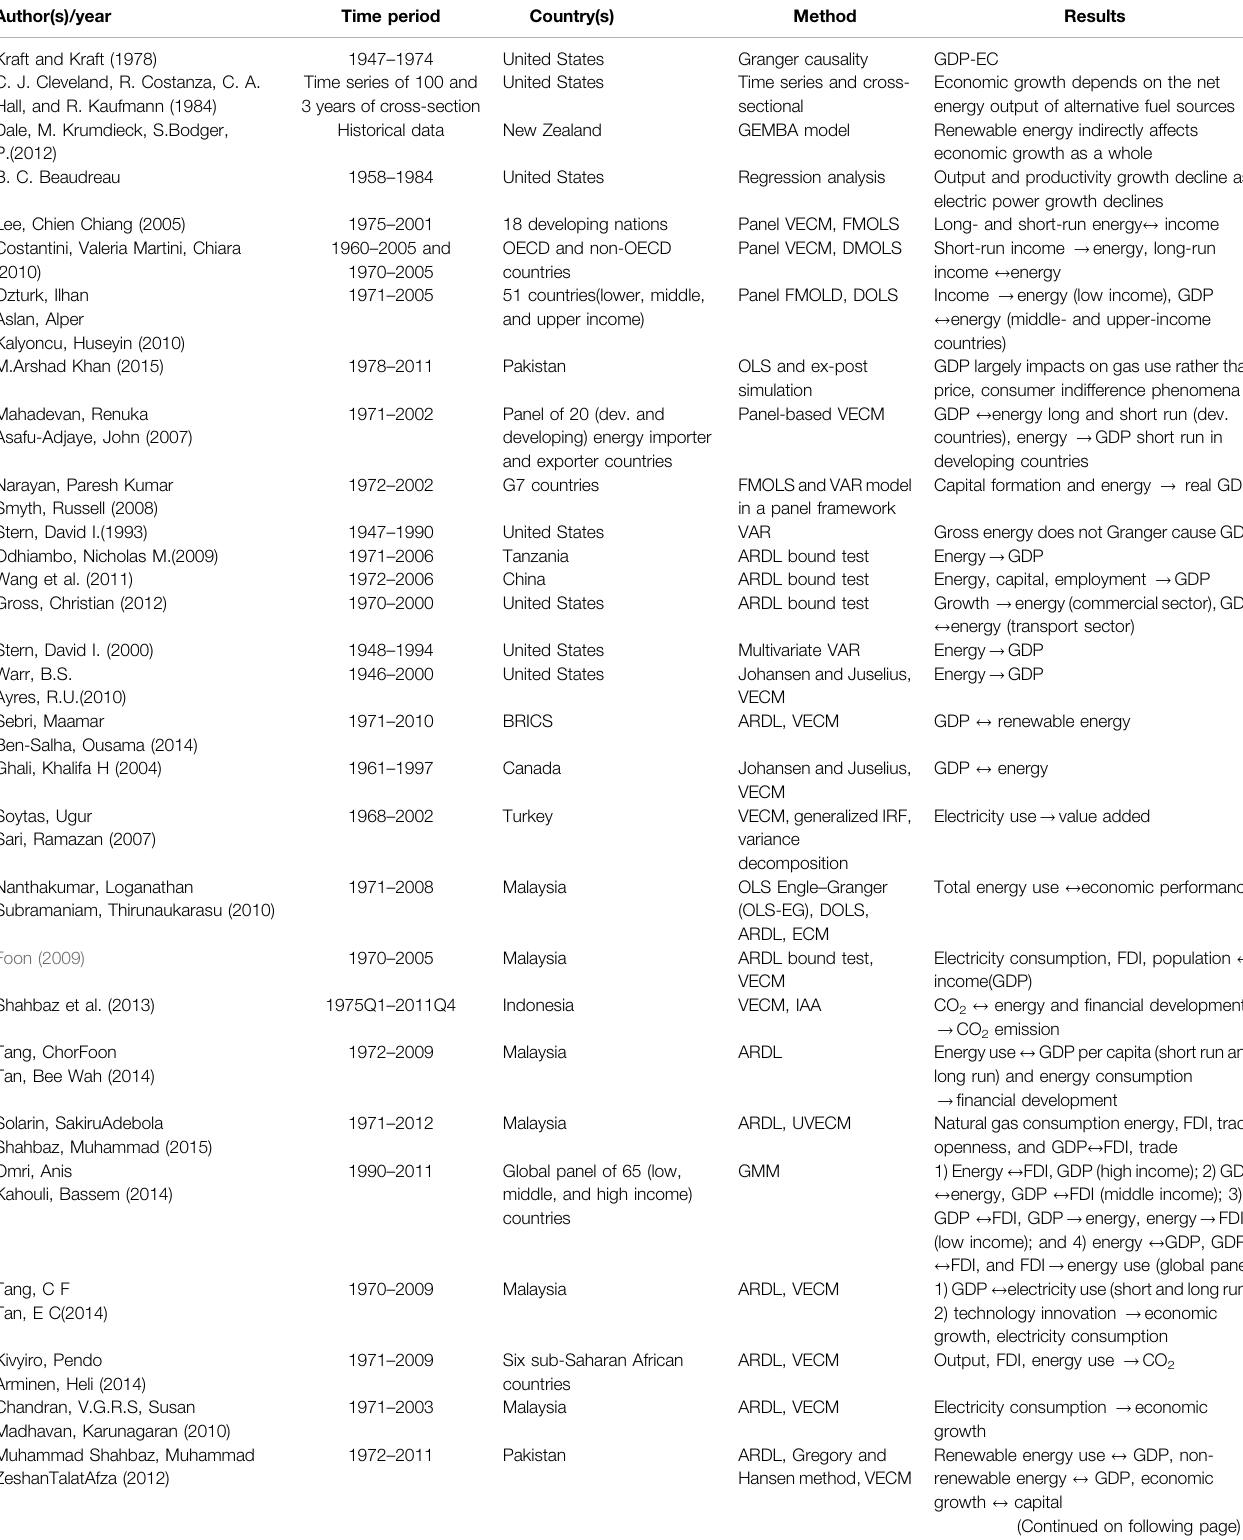
TABLE 1 | Literature